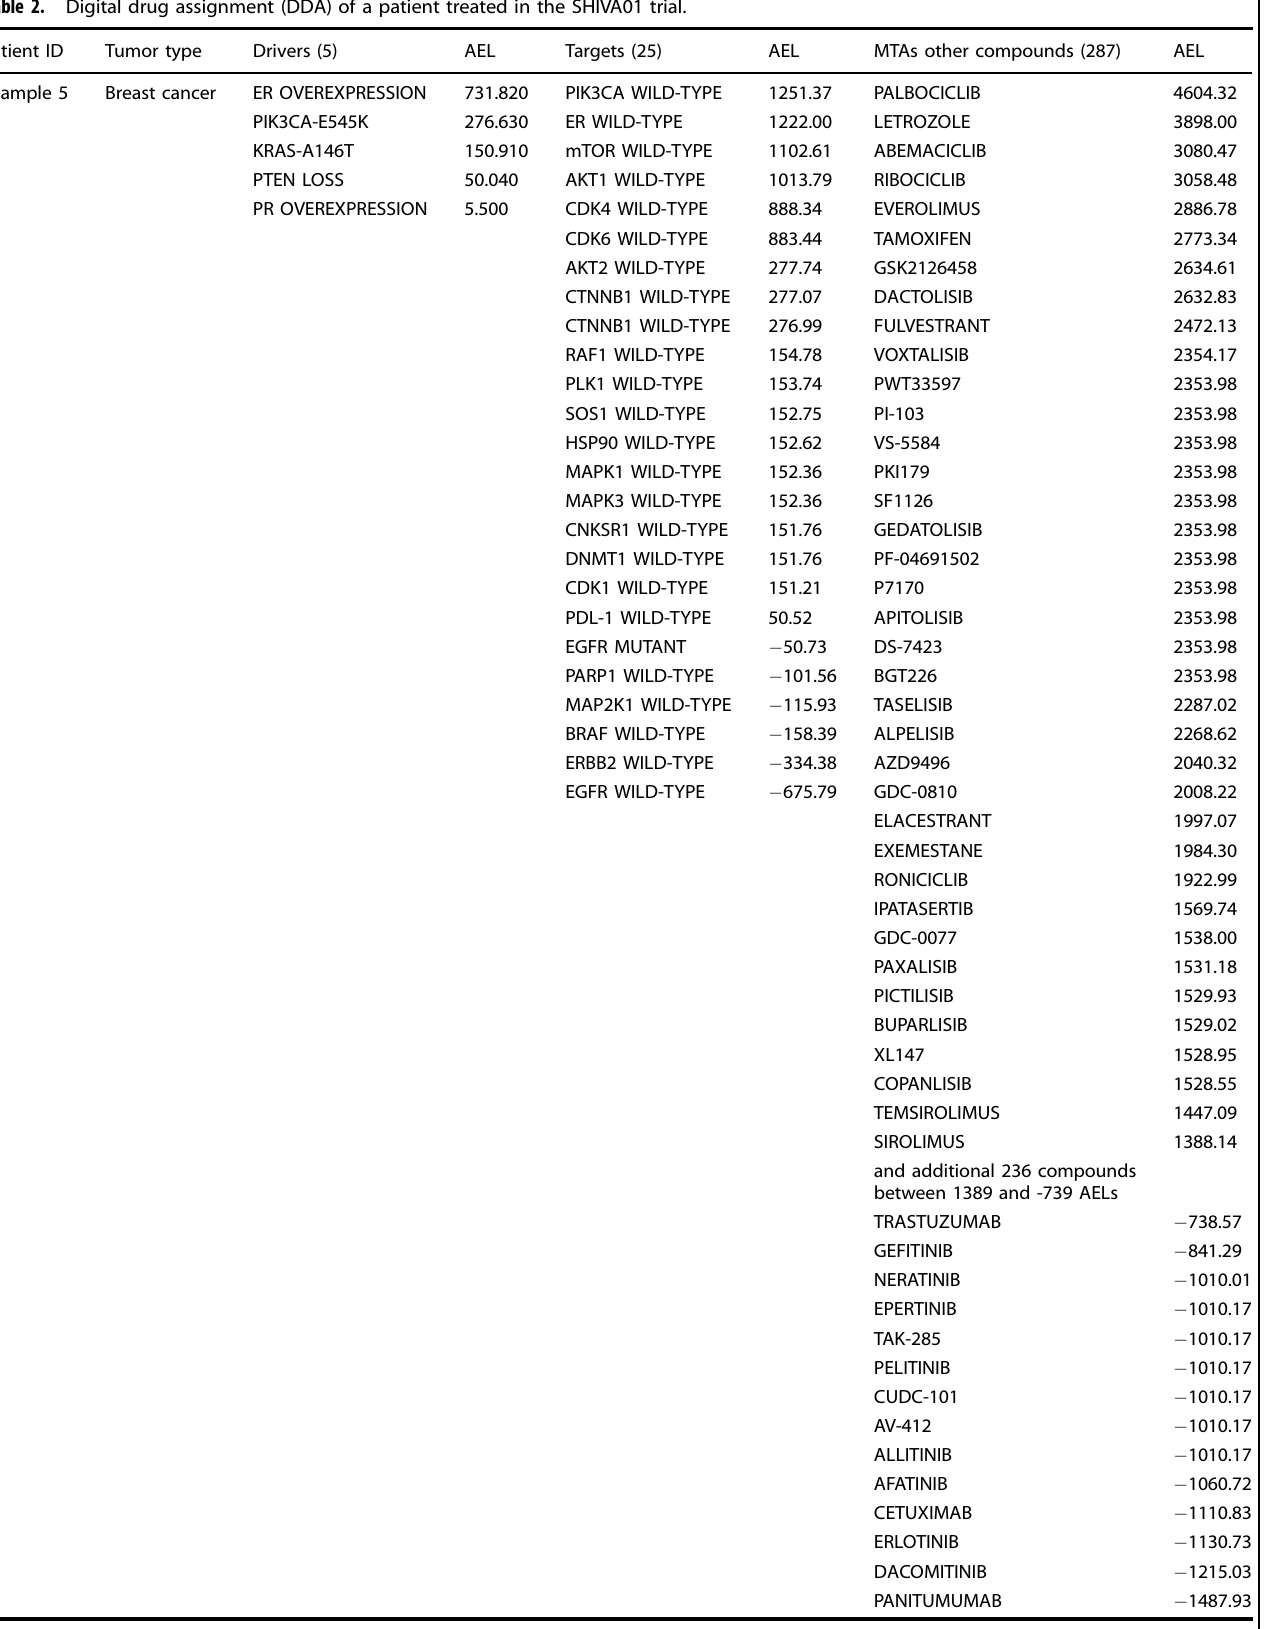
Table 2. Digital drug assignment (DDA) of a patient treated in the SHIVA01 trial. Patient